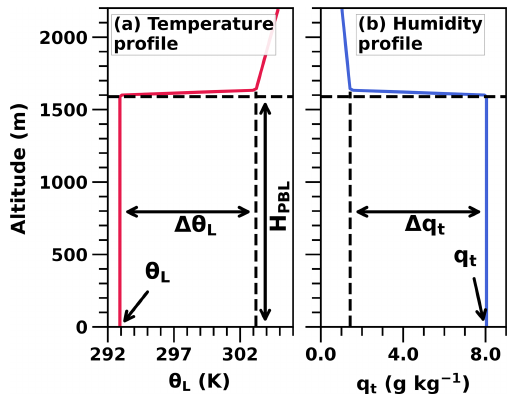
Figure 3. An example of the initial atmospheric profiles generated from the meteorological input